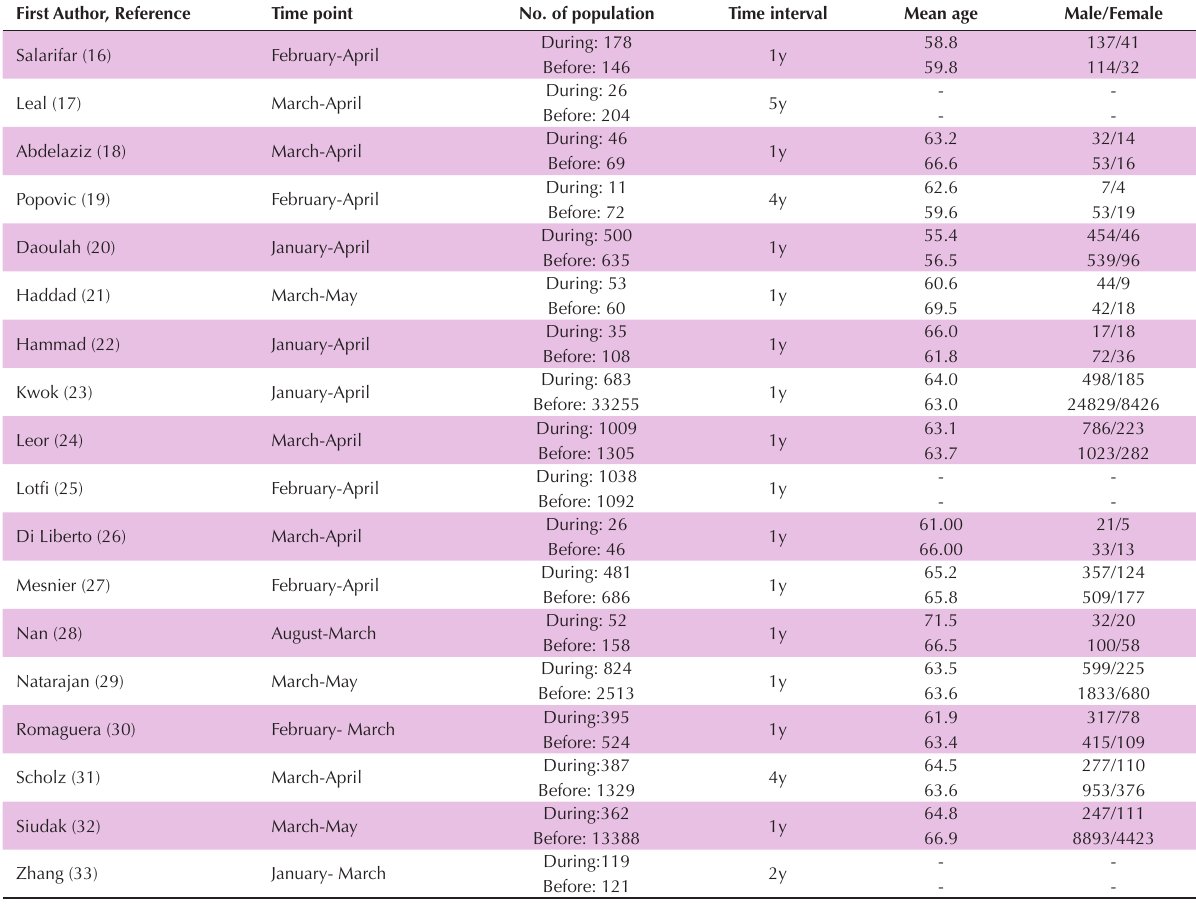
Table 1. The baseline details of studies included in our